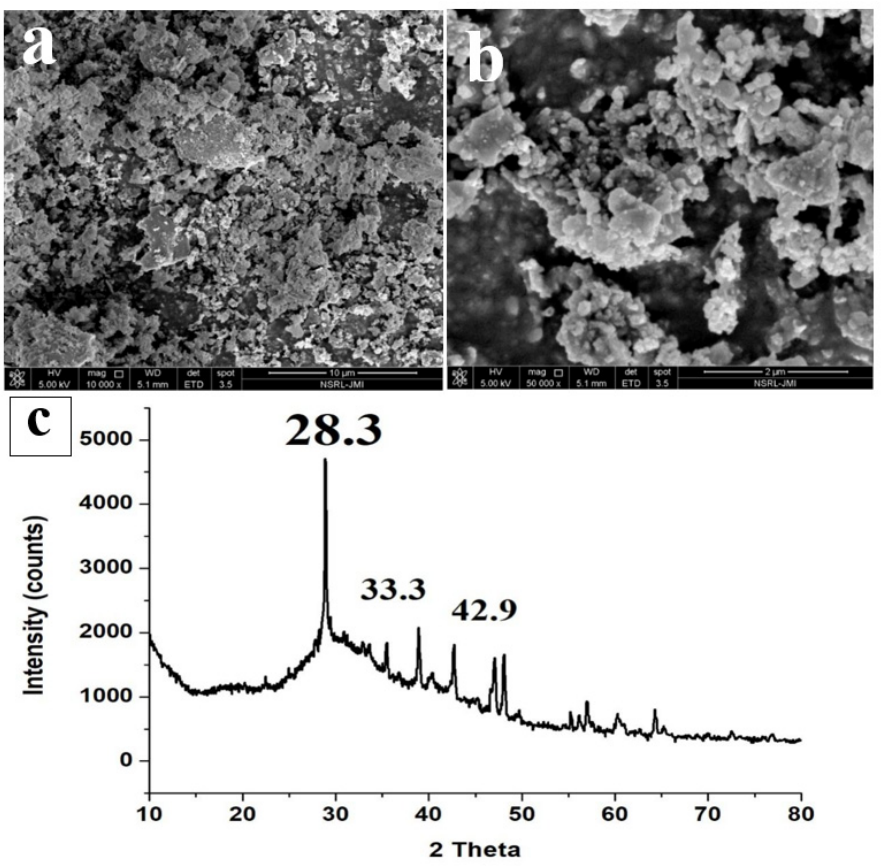
Figure 6. FESEM micrographs ( a , b ) and XRD ( c ) of ISA.